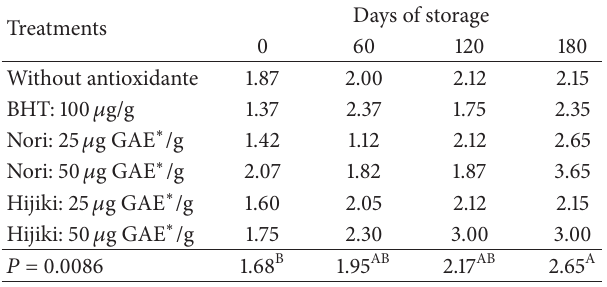
Table 6: Sensory analysis for the rancid aroma of minced